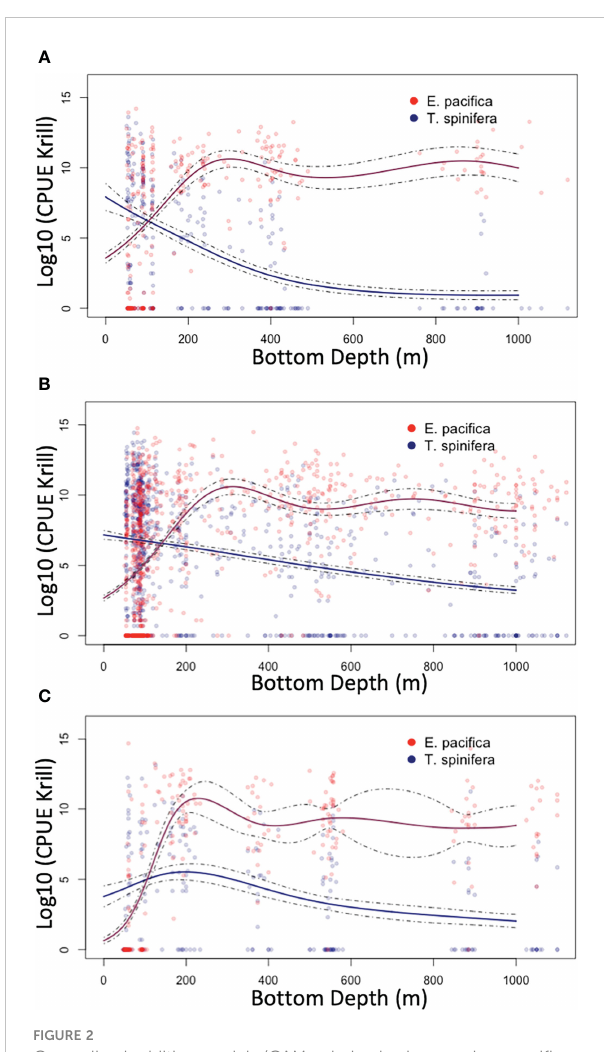
FIGURE 2 Generalized additive models (GAMs; derived using species-speci fi c trawl catch per unit effort data) that were used to partition the acoustic signal into Euphausia paci fi ca (red) and Thysanoessa spinifera (blue) by depth: north of the core region (A) , within the core region (B) , and south of the core region (C)